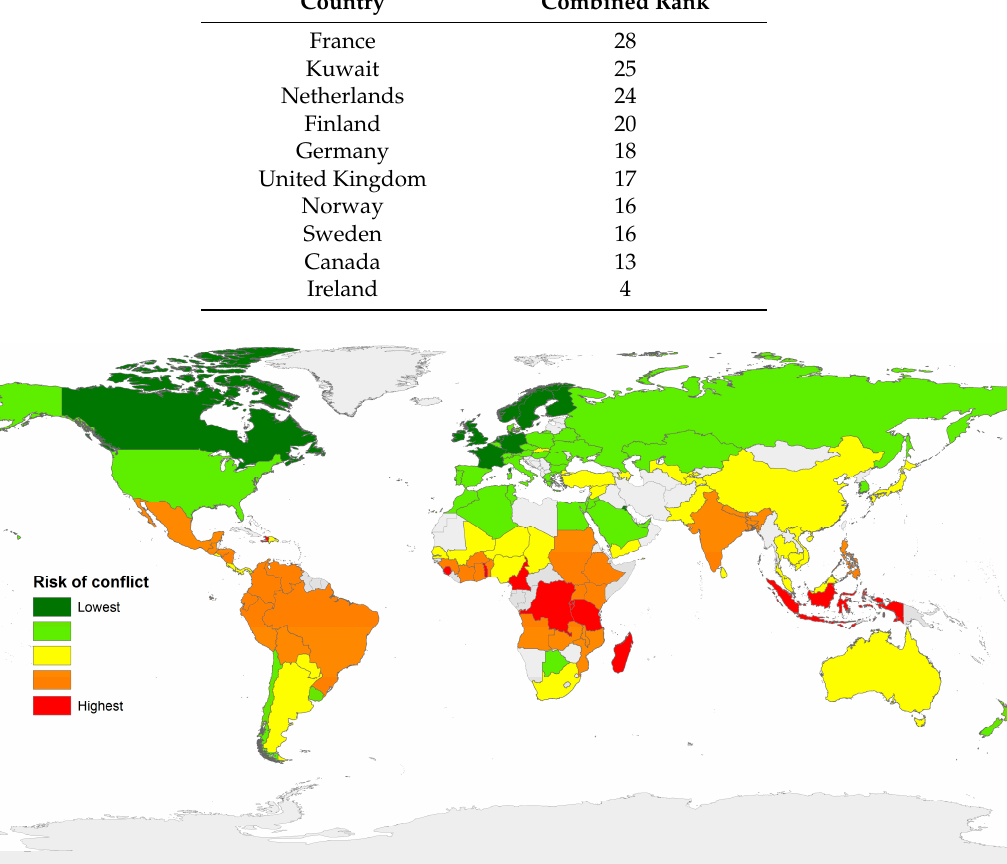
Figure 2. Index of conflict risk between food security and biodiversity.